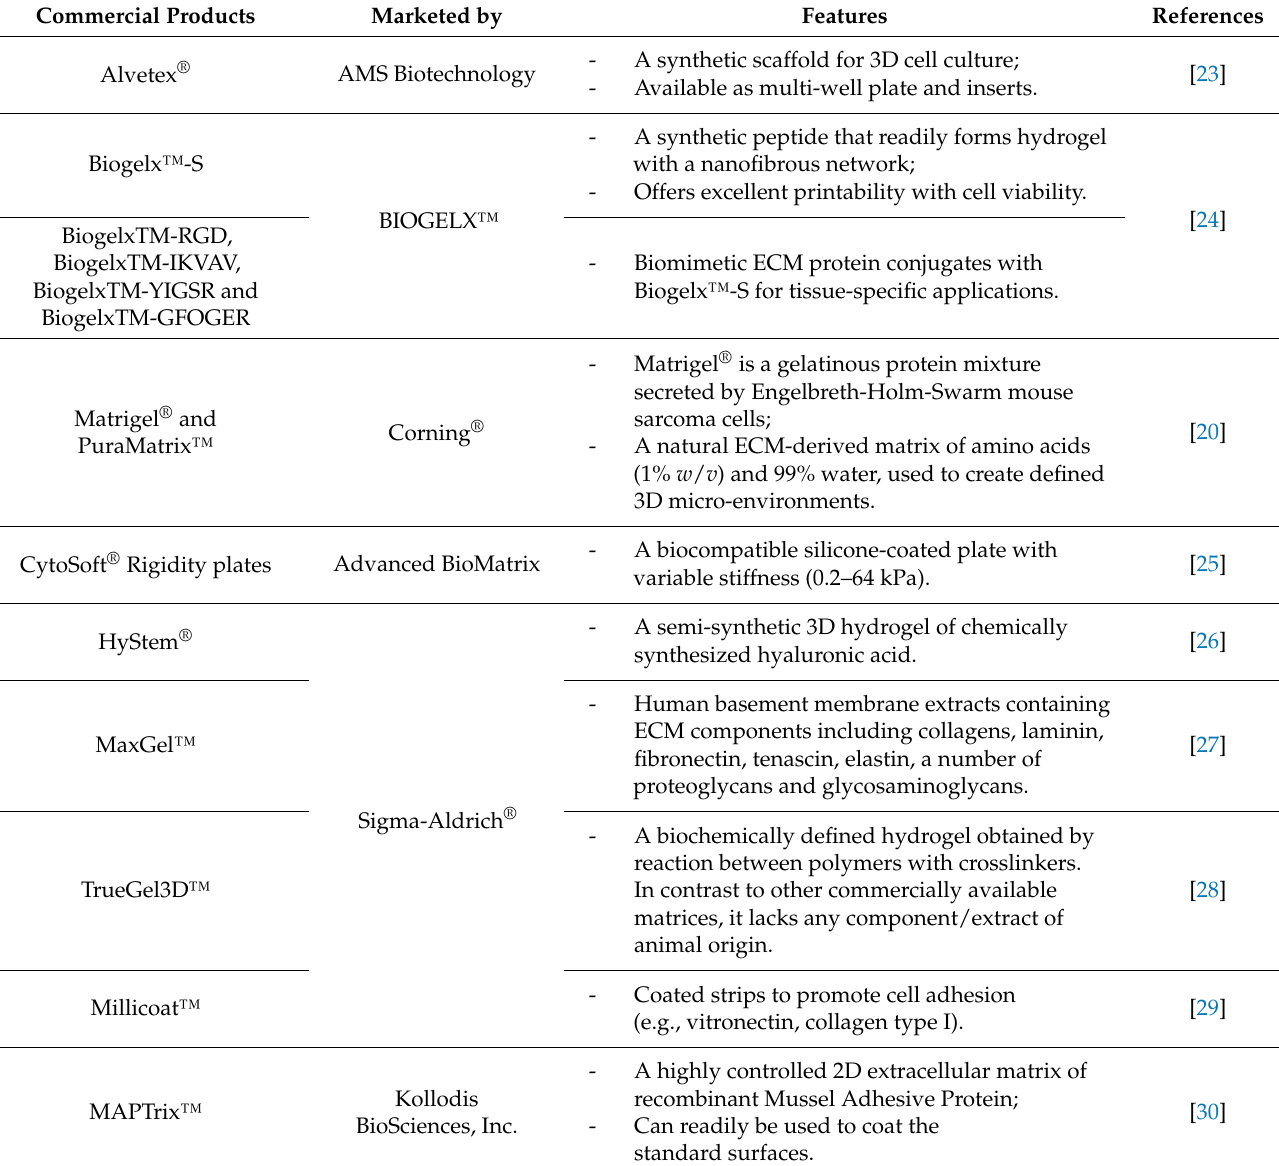
Table 2. Different types of commercially available scaffolds/matrices for 3D cell